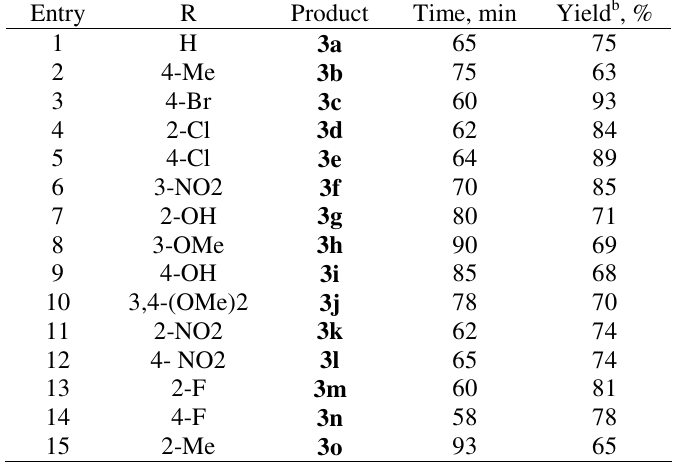
Table 2. Synthesis of 2,4,5-tripheny-1 H -imidazole derivatives in the presences of ZnO